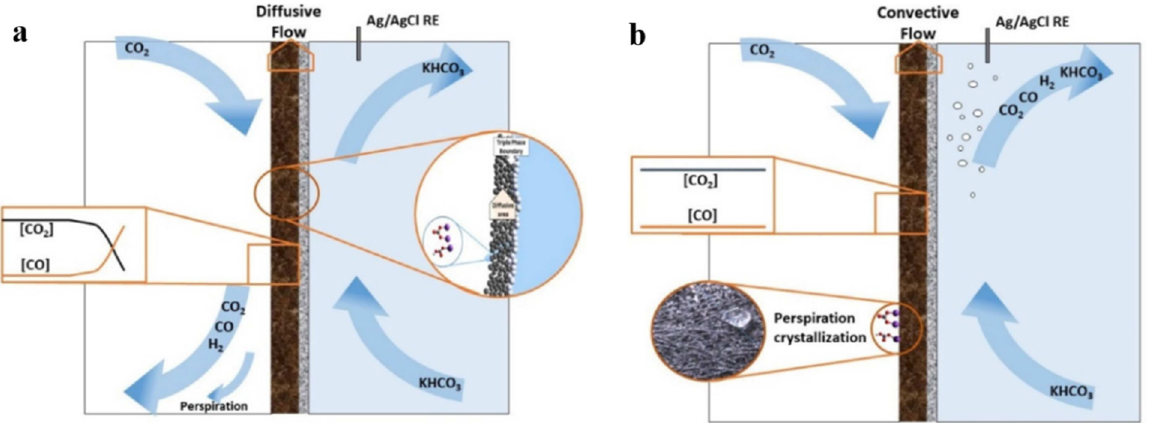
Figure 15. Illustration of two flow patterns: ( a ) flow-by pattern and ( b ) flow-through pattern. Reproduced with permission from Ref. [123]. Copyright 2019 Wiley-VCH Verlag GmbH & Co. KGaA, Weinheim.